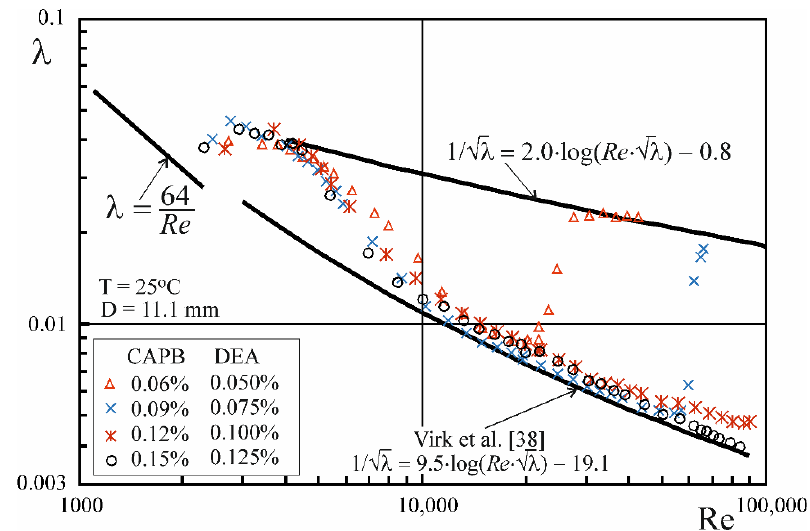
Figure 5. The effect of total CAPB/DEA concentration on the course of λ = f ( Re ).